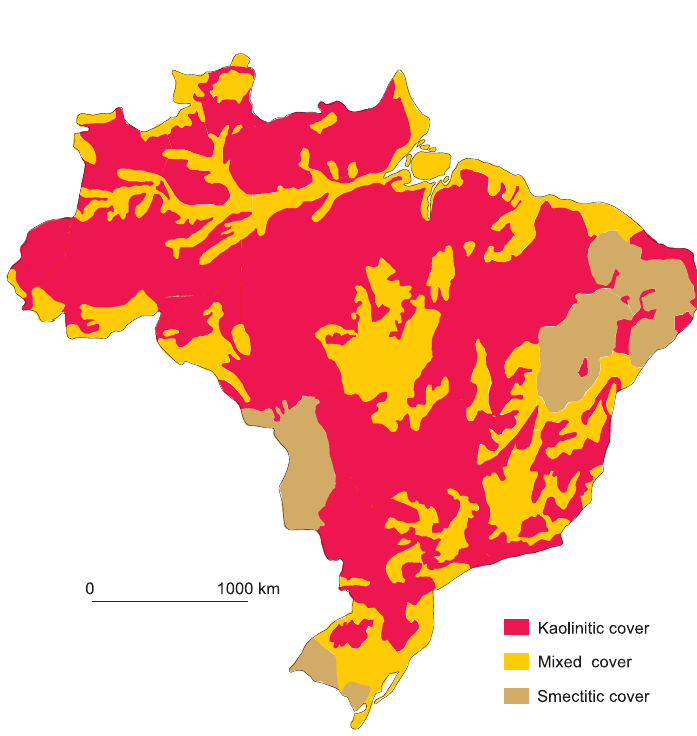
Fig. 1 – Distribution of different pedological covers in Brazil.